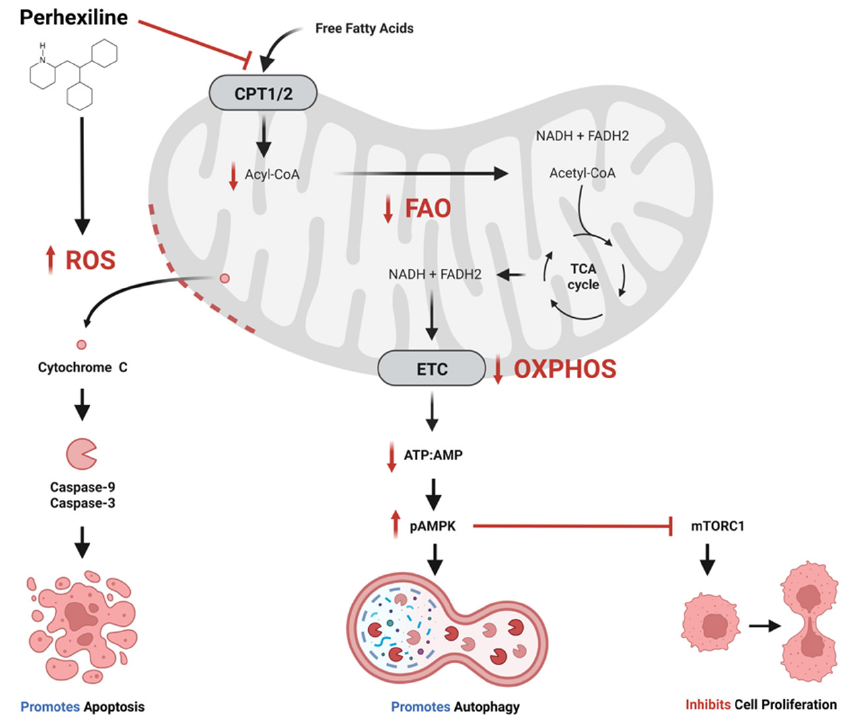
Figure 1. Proposed anti-cancer effects of perhexiline. Perhexiline inhibition of carnitine palmitoyl- transferase 1 (CPT1) and CPT2 restricts the entry of free fatty acids into the mitochondrial matrix, thereby inhibiting fatty acid oxidation (FAO). This may limit the production of the electron transport chain (ETC) co-enzymes nicotinamide adenine dinucleotide (NADH) and flavin adenine dinucleotide (FADH2), which would inhibit oxidative phosphorylation (OXPHOS) and the generation of adeno- sine triphosphate (ATP). A reduction in ratio of ATP to adenosine monophosphate (AMP) activates AMP-activated protein kinase (AMPK) by phosphorylation (pAMPK). pAMPK triggers autophagy, and inhibits cell proliferation by inhibiting mammalian target of rapamycin complex 1 (mTORC1). Additionally, perhexiline increases the level of reactive oxygen species (ROS), which compromises mitochondrial membrane integrity, leading to the release cytochrome c and activation caspases that initiate apoptosis. Created with